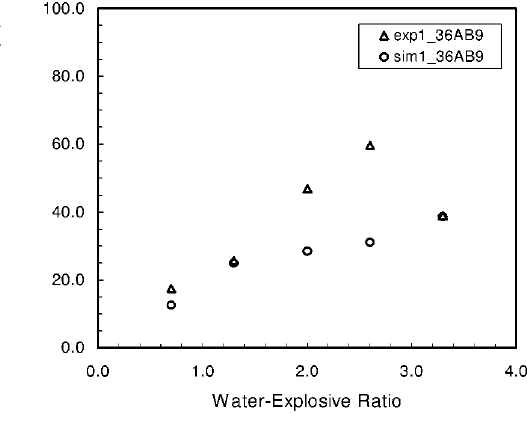
Fig. 12. Comparison between experiment and computation for 1.36 kg C4 charge detonation with water ( R = 3 : 3).